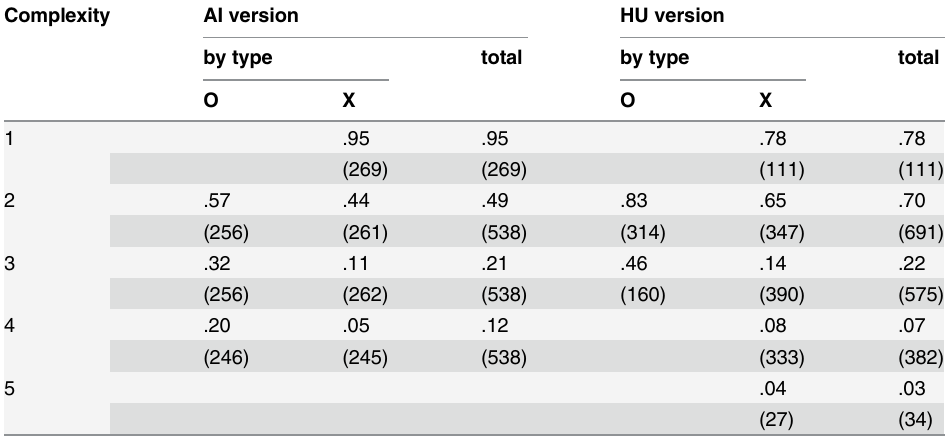
Table 7. Solved df games by complexity, version, and player ’ s type. Observations in